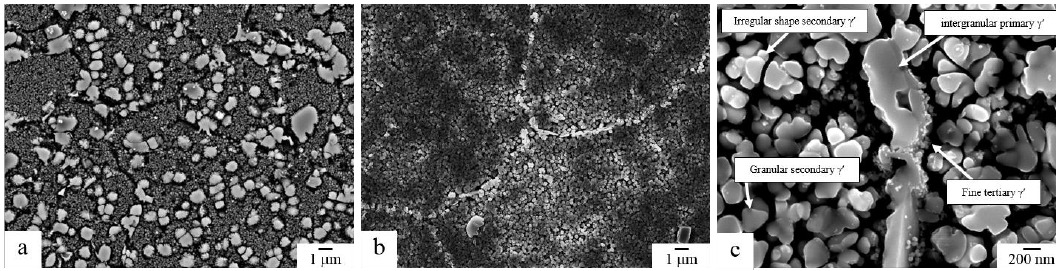
Figure 2. Microstructures of the D2 alloy as-received ( a ), as-solution-heat-treated ( b ), and as-solution-treated viewed at high magnification ( c ).